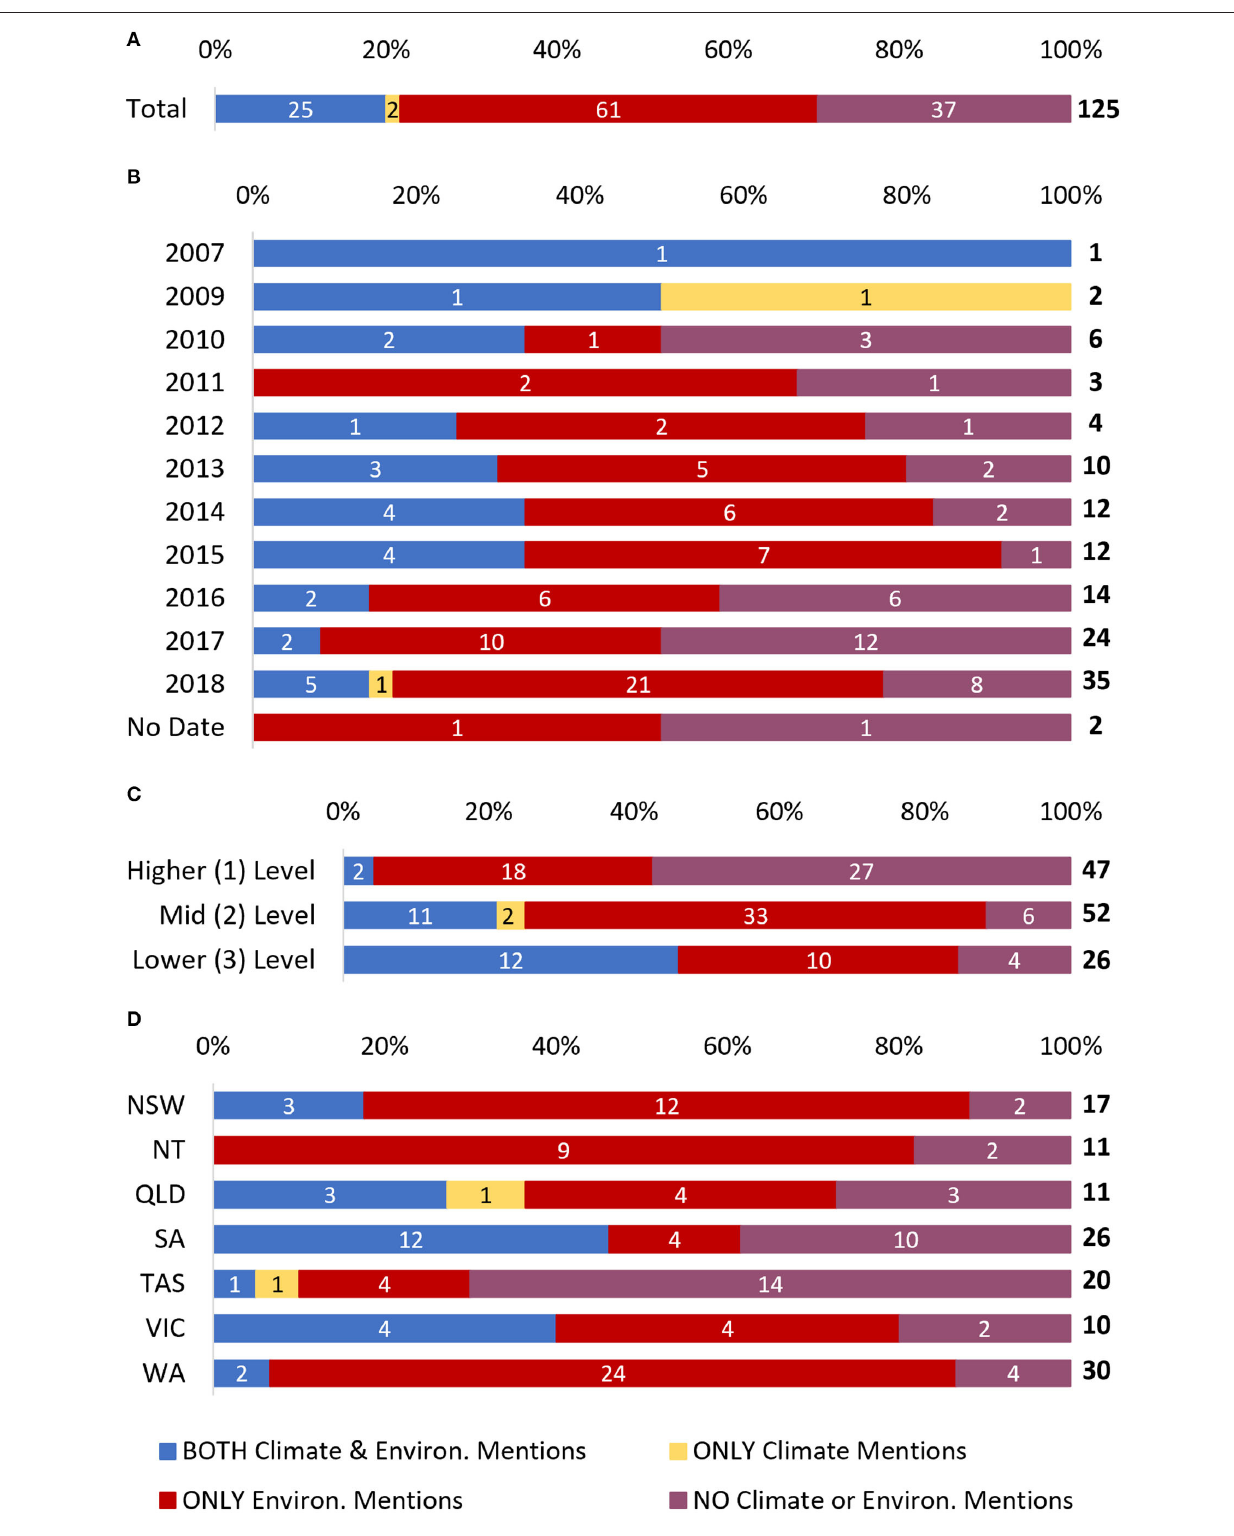
FIGURE 4 | The percentage and count of the number of fisheries management documents with climate-related mentions (“climate”), mentions of environmental protection considerations (“environ.”), or none of the above, separated by; (A) All documents as one group; (B) The year of publication of the current document version; (C) Hierarchical level of management document; and (D) Australian state where the document is relevant to. NSW, New South Wales; NT, Northern Territory; QLD, Queensland; SA, South Australia; TAS, Tasmania; VIC, Victoria; WA, Western Australia. Data labels represent the count of documents for each category, with the labels to the right of the bars representing the overall counts of management